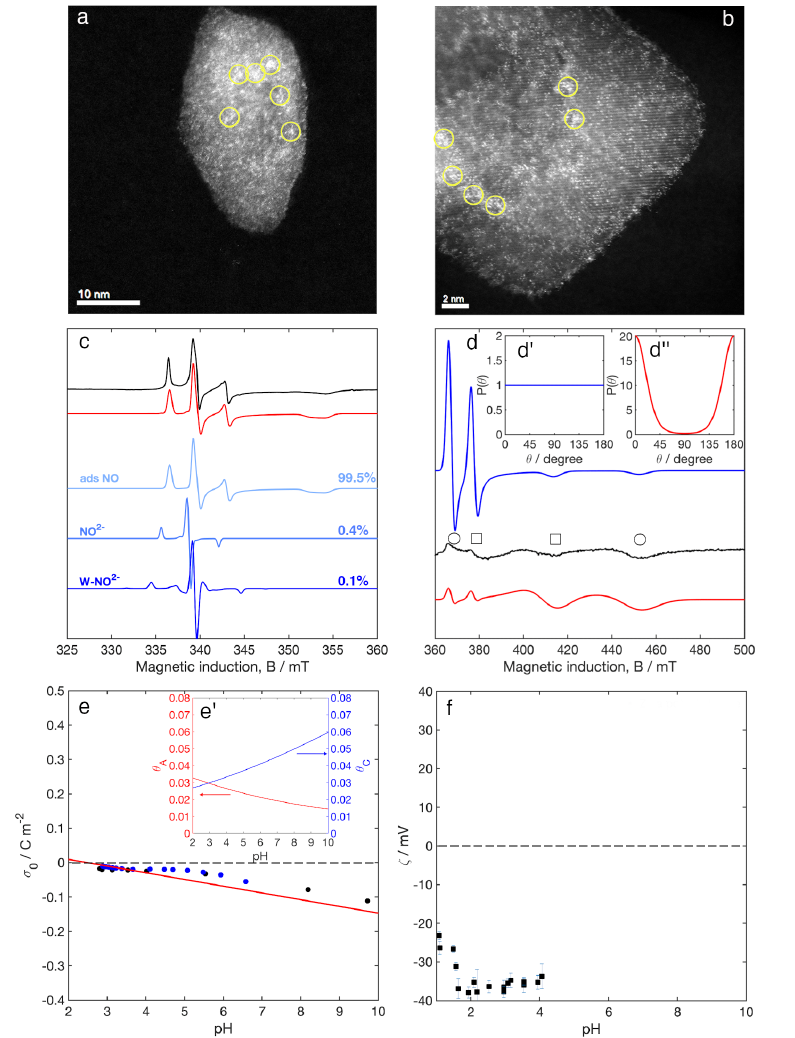
Figure 2. Ti 0.909 W 0.091 O 2 N x : ( a , b ) Representative HAADF-STEM images. The presence of both sub- stitutional W (brighter dots) and W-containing surface clusters (extended brighter areas highlighted by yellow circles) are evident in the images. ( c ) Experimental (black) and simulated (red) X-band CW EPR spectra recorded at 50 K around the free-spin region. The simulated spectrum is deconvoluted into its three components. The relative spectral contributions are 99.5% adsorbed NO, 0.4% NO 2– and ~0.1% W NO 2– . ( d ) Experimental (black) and simulated (red and blue) X-band CW EPR spectra measured at 50 K at higher magnetic induction. The relative spectral contributions are 66.7% W 5+ in W x O y (circles) and 33.3% W 5+ in W bronzes superstructures (squares). The blue simulation refers to a powder spectrum with orientational probability distribution of the paramagnetic W 5+ centres given by inset ( d’ ). The red simulation refers to a powder spectrum with orientational probability distribu- tion of the paramagnetic W 5+ centres given by inset ( d” ). The experimental spectra were recorded at 100kHz field modulation frequency, 0.2mT field modulation amplitude, 2µW microwave power, and 72dB receiver gain. ( e ) Experimental (discrete points) and simulated (red solid line) surface charge density plot at constant ionic strength I = 10 − 2 molL − 1 . Both black and blue points are the experimental σ 0 obtained from the mass titrations in Figure S1 and are two different replicates of the same measurement. Inset ( e’ ) shows the simulated surface sites speciation relative to the surface site complexes with cations (Na + ) and anions (NO – 3 ). ( f ) Experimental electrokinetic ( ζ ) potential measured at constant ionic strength I = 10 − 2 molL − 1 using the laser doppler microelectrophoretic